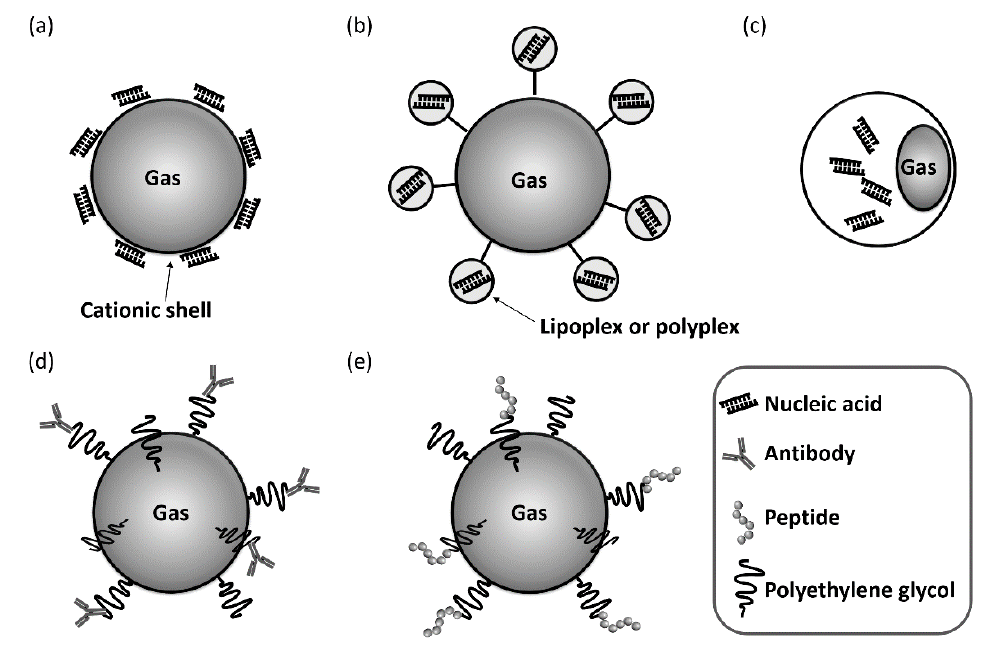
Figure 3. Various types of functionalized bubbles for nucleic acids systemic delivery. ( a ) an electrostatically nucleic acid-loaded bubble ( b ) an complexes-loaded bubble ( c ) a nucleic acid-encapsulated bubble ( d ) an antibody-modified bubble ( e ) a peptide-modified bubble.